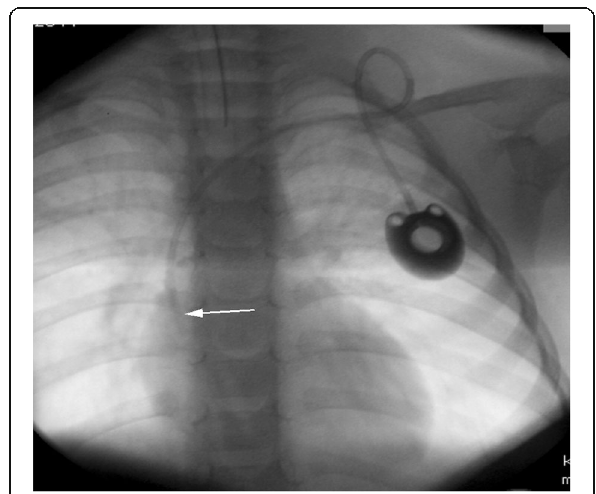
Fig. 3 Patient 2 intra-operative fluoroscopic picture. CVC inserted into the posterior branch of the EJV and was threaded easily towards the right atrium. The white arrow is pointing to the tip of the central venous